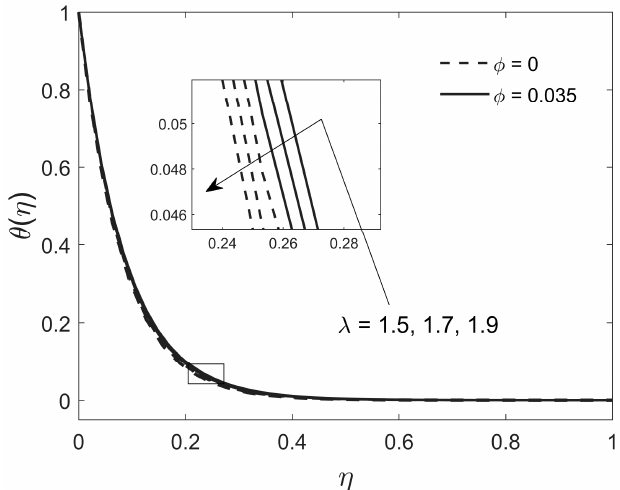
Figure 12. Effect of stretching/shrinking on the temperature distribution.